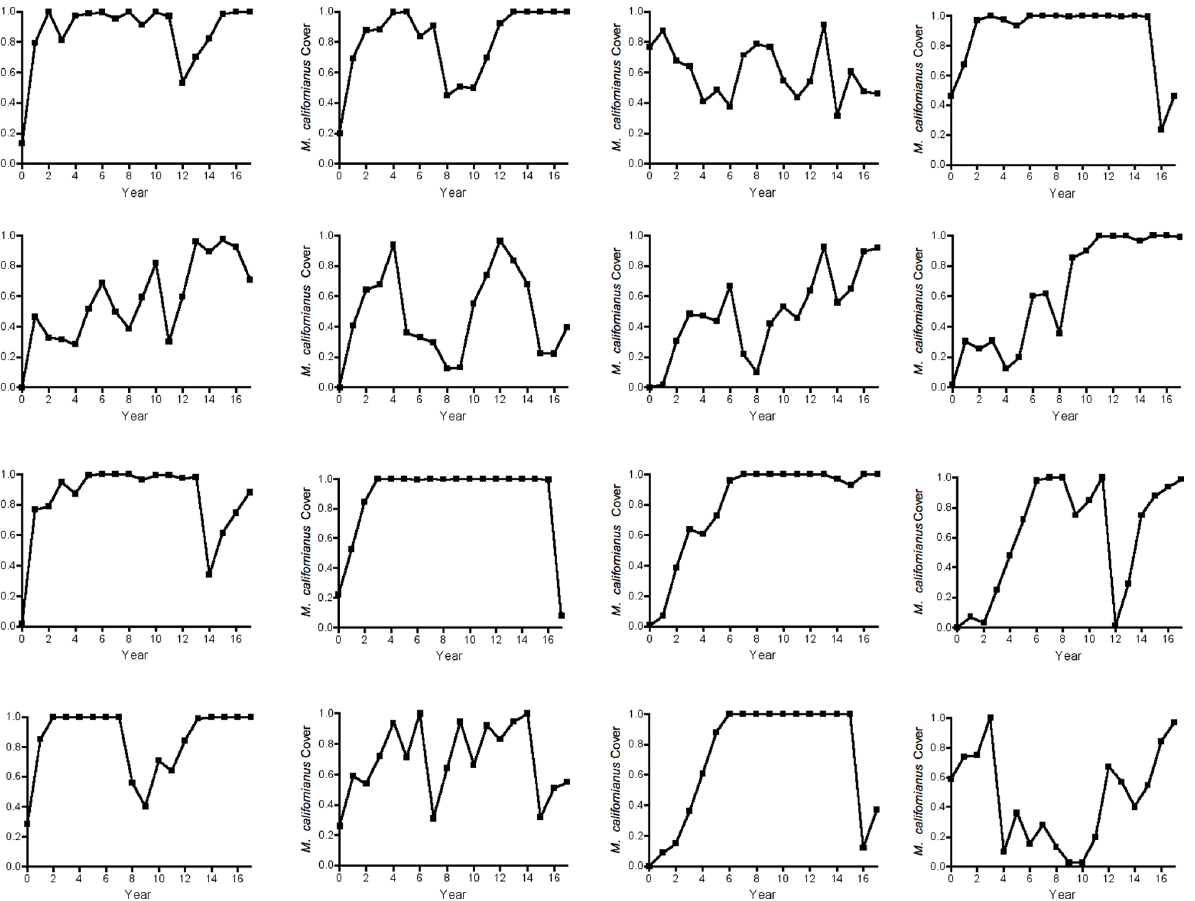
Figure 4. Graphs of 16 simulations of Mytiluscalifornianus population dynamics. Simulations used the best-fitting deterministic model skeleton with an added constant stochastic term (Equation 2, Table 1).